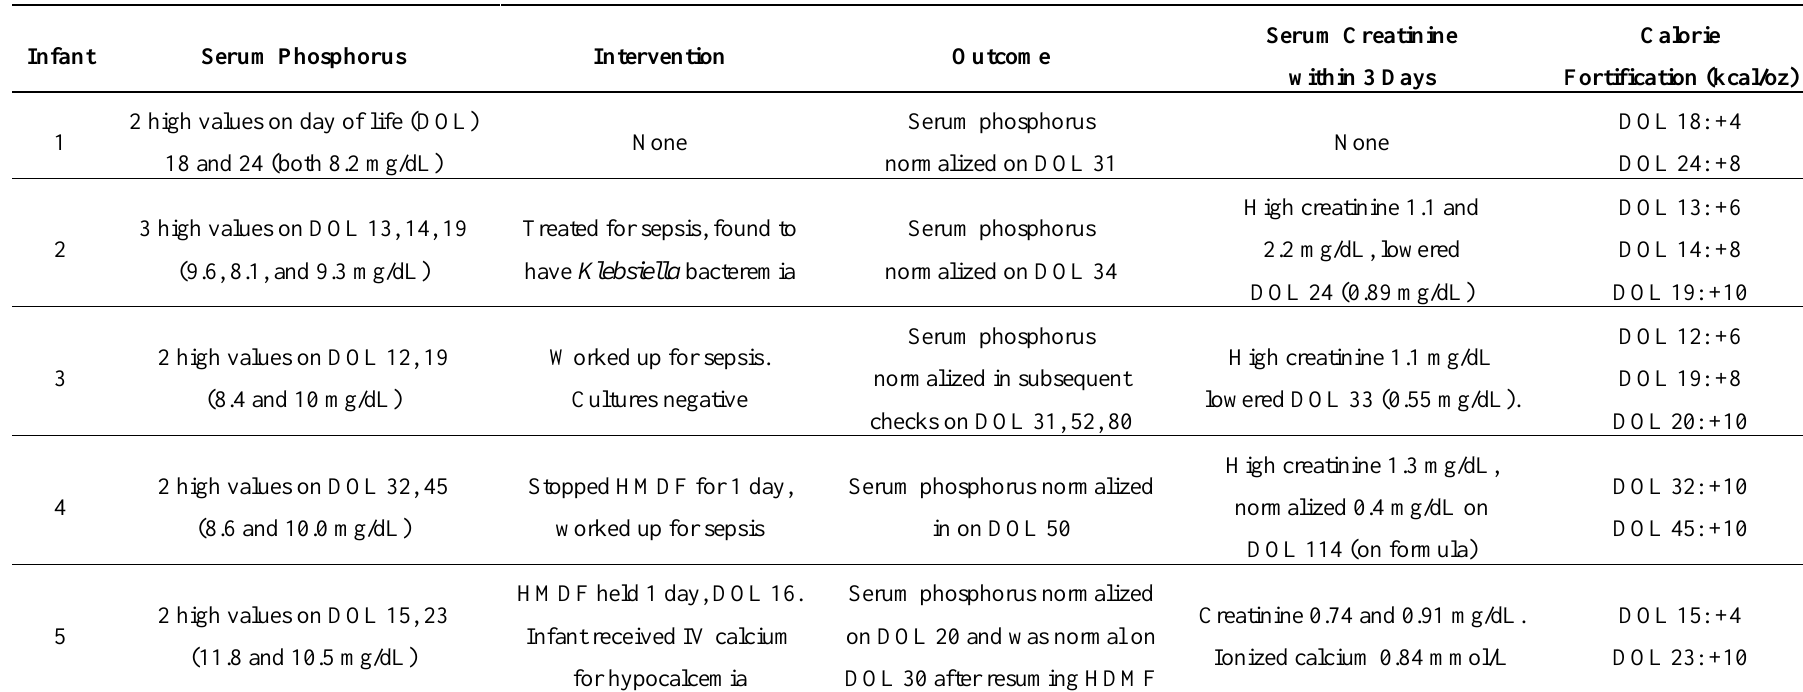
Table 4. Outcomes of infants with multiple high serum phosphorus